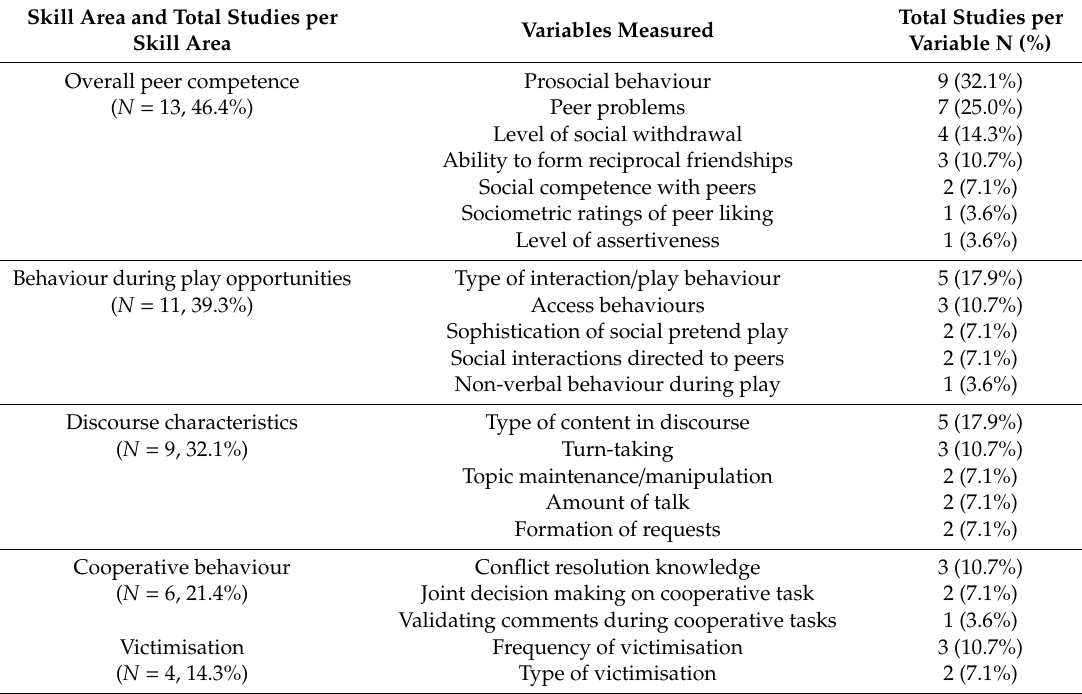
Table 4. Table to show the total number of studies measuring di ff erent variables related to peer interaction skills within identified skill areas. Each study could include multiple variables within multiple skill